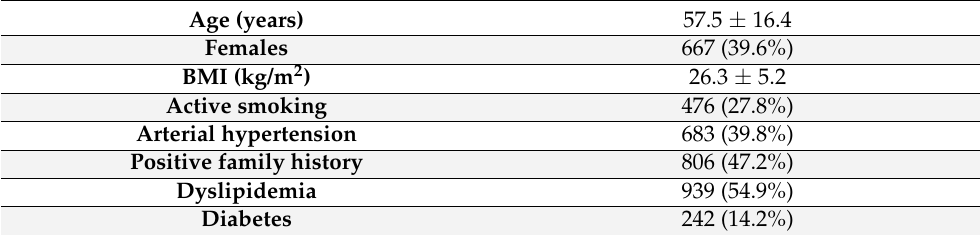
Table 1. Study population ( n = 1709).